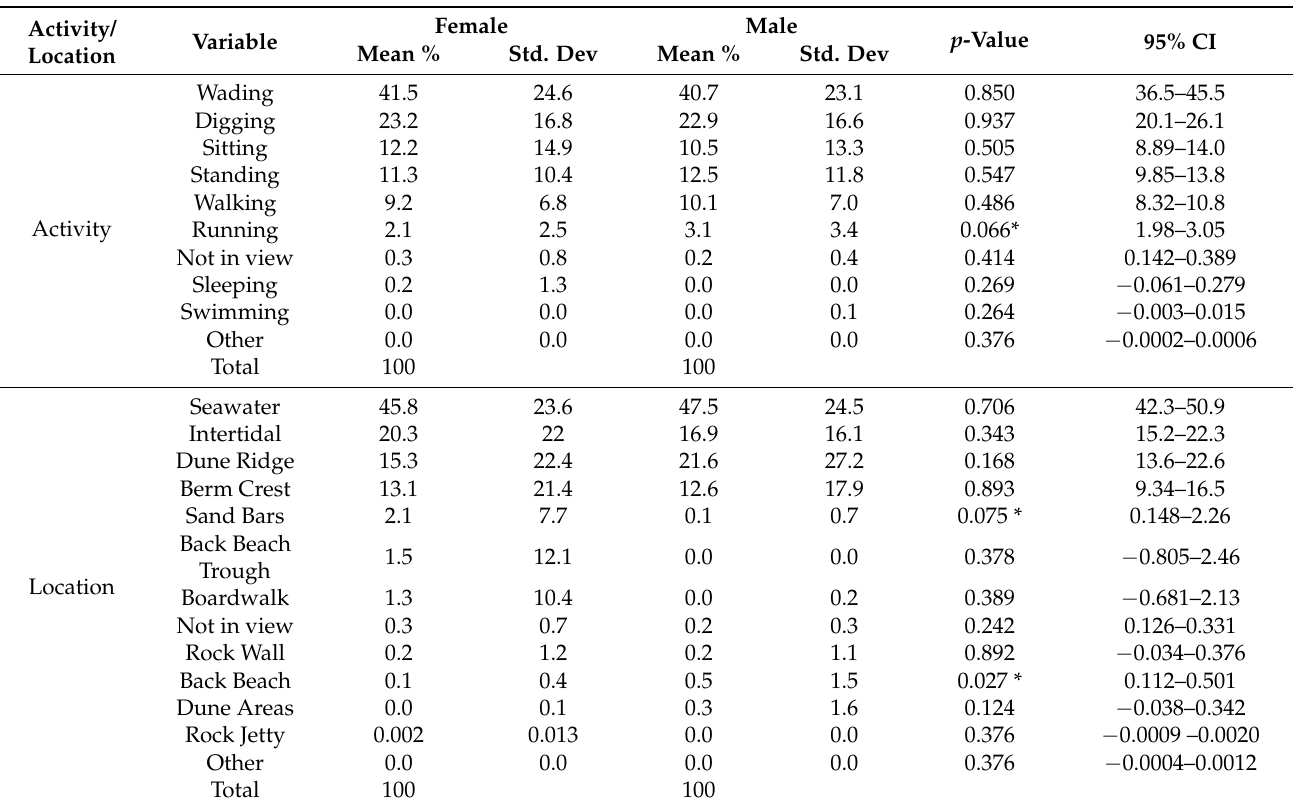
Table 3. Mean Percent Time Spent Engaged in Various Activities and Locations for Children by Sex (females, n = 67, males, n = 53).